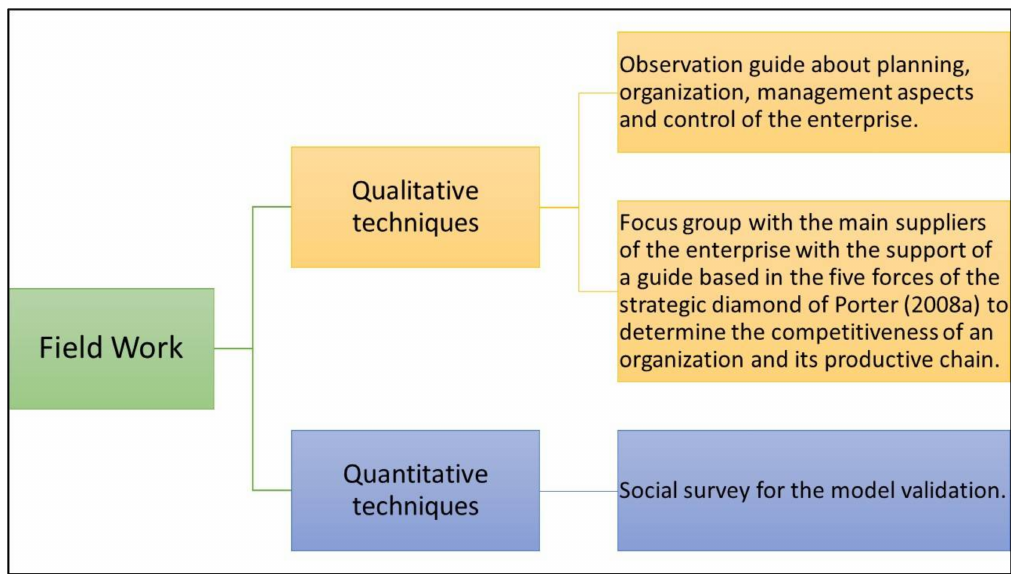
Figure 3. Hybrid methodological design. Author’s